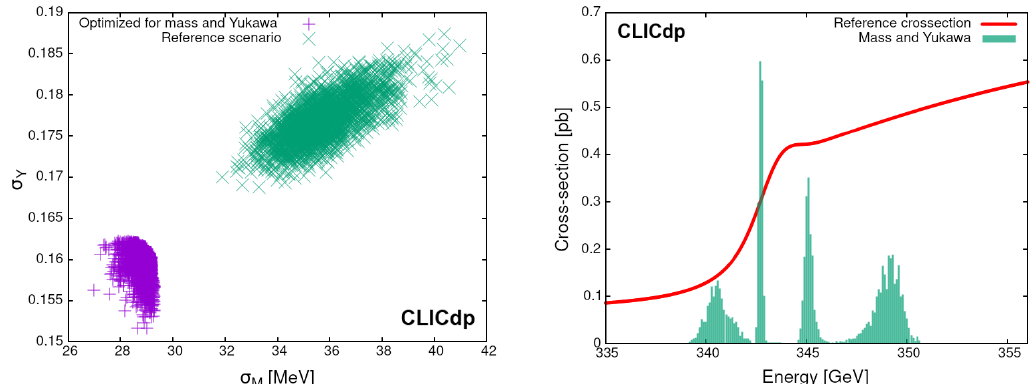
Figure 2: As in Fig. 1 but for mass and Yukawa coupling measurement optimisation. Figure reproduced from [ 2 ]